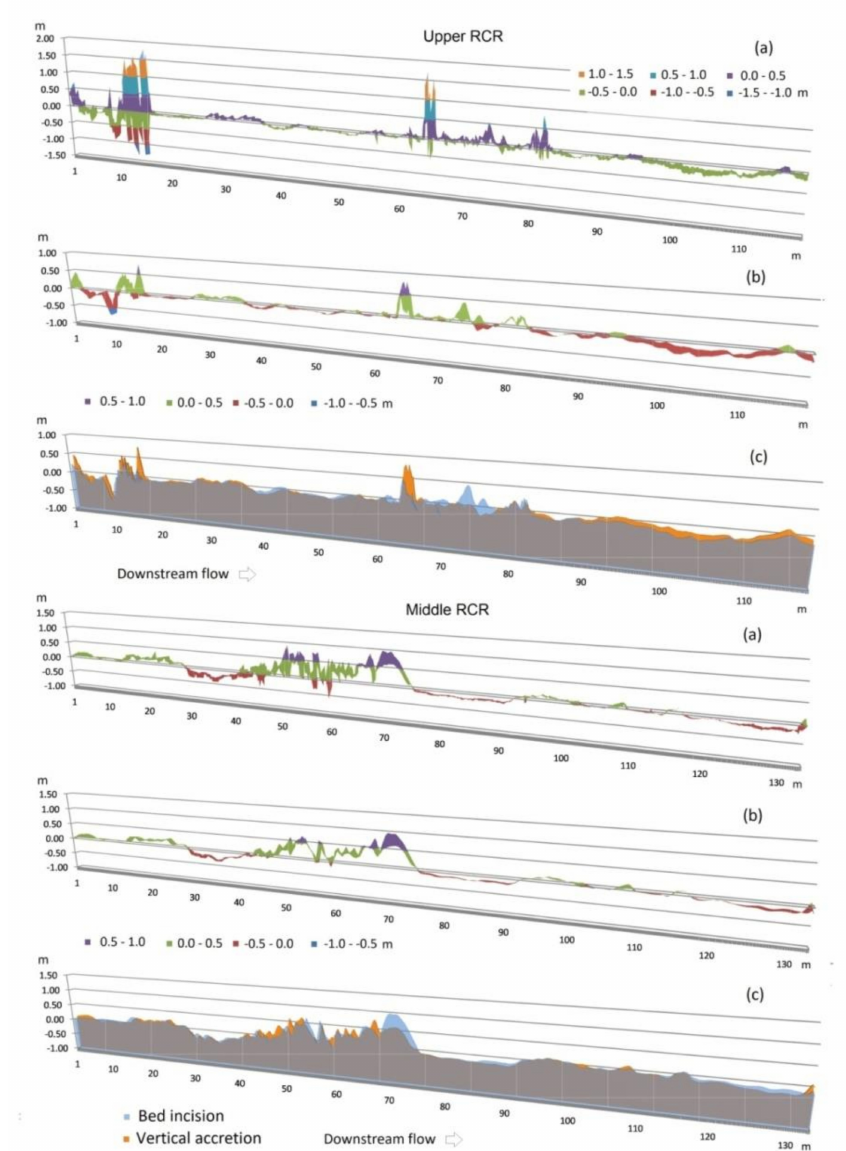
Figure 10. Thickness of the bed elevation di ff erences caused by the flow peak of September 2019 in relation to those attributed to the flood of April 2019, using gross data with a 10-cm interval ( a ) and moving averages of band 9 ( b ) along the channel center line. The type ( c ) profiles represent the incision and aggradation sites for both peak flows with a band 9 smoothing. The profiles are based on TLS